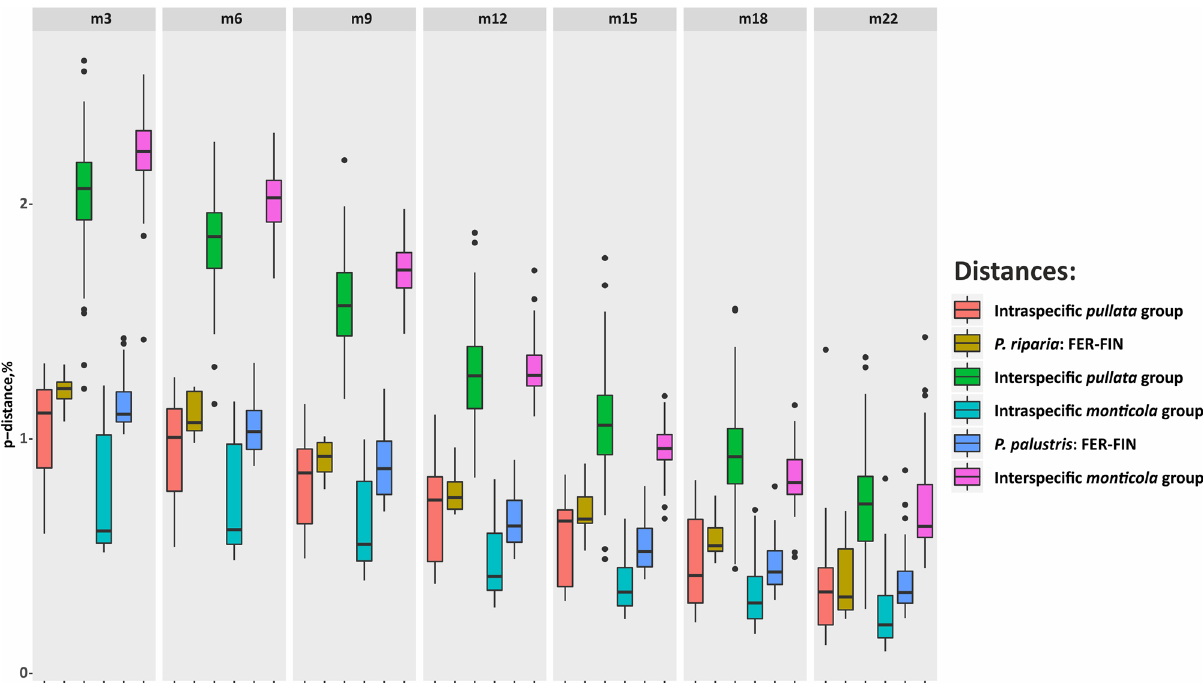
Figure 4. Boxplots of absolute values of p -distance. Each section represents Rip_pal_ datasets assembled at a particular m value indicated at the top of the section. The p -distances for pullata and monticola species groups and between focus populations of P. riparia and P. palustris are calculated separately. Boxplots show median, quartiles and 95% confidence intervals.